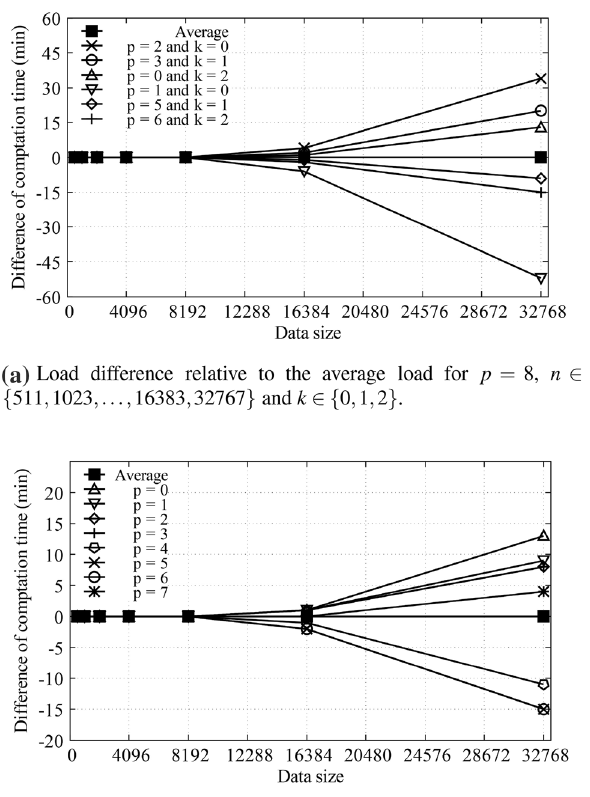
Fig. 11 Load difference relative to the average load in function of